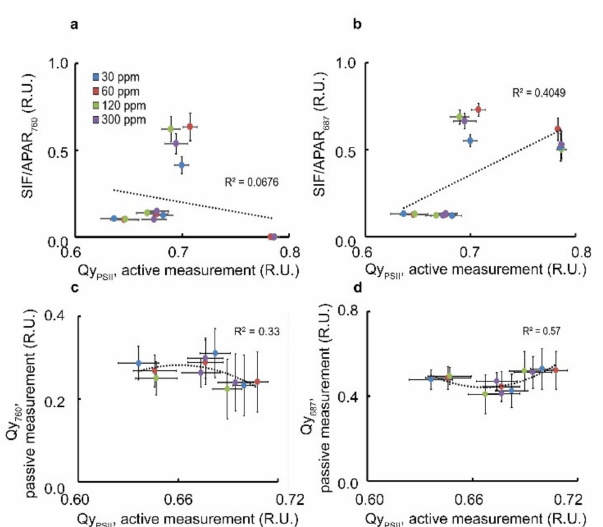
Figure 4. Comparison of remote sensing quantum yield calculations with Pulse Amplitude Modulation (PAM) technique in L. sativa . Panels ( a , c ) and panels ( b , d ), represent calculations with SIF 760 and SIF 687 , respectively. Color code of blue, red, green and purple, resembles four fertilization concentrations of 30, 60, 120, and 300 ppm respectively. Each point represents 30 repeats and error bars are standard errors of the